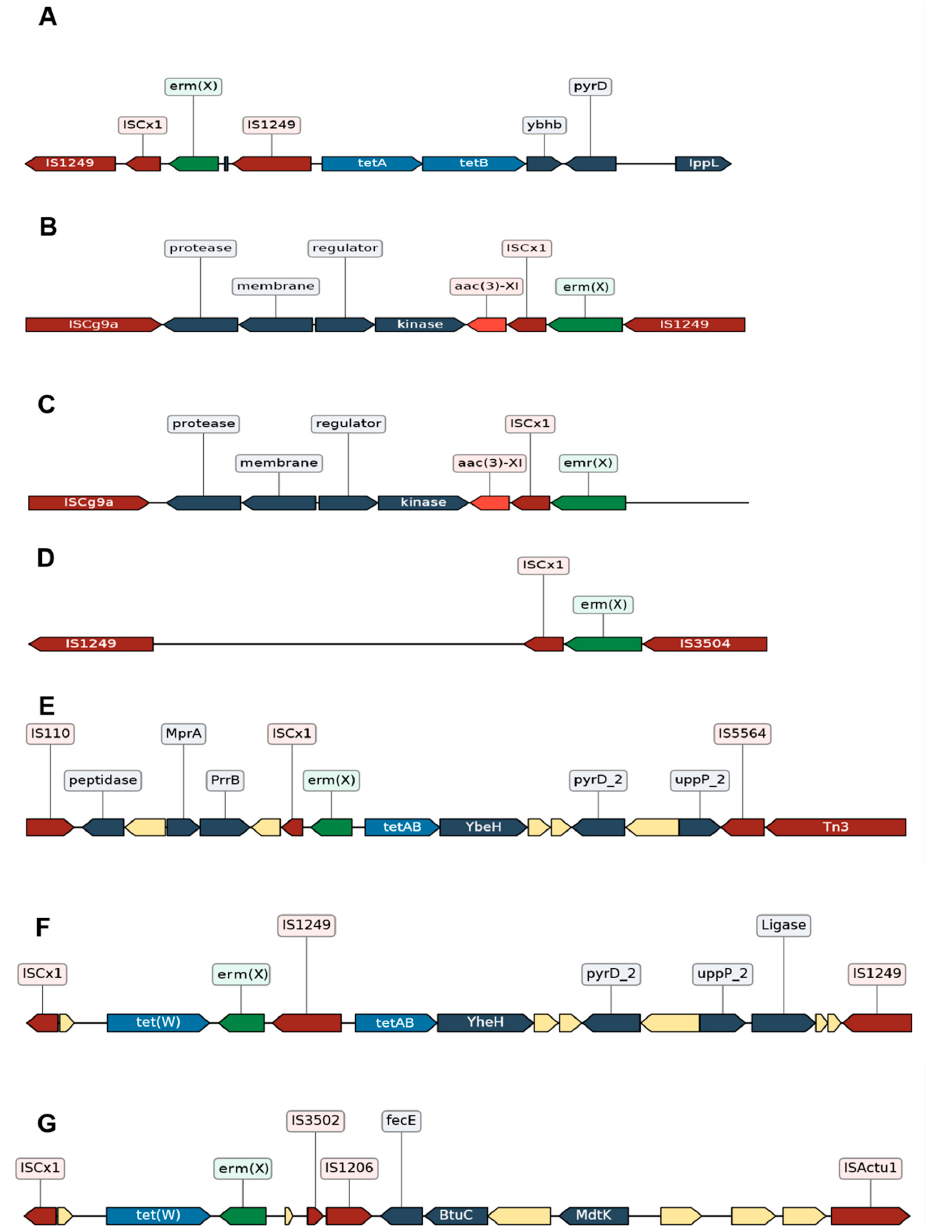
Figure 2. Genomic context of Tn5432 . Illustrated sequences from the genomic context of Tn5432 found in studies by Nudel et al., 2018; Tauch et al., 2000; Wang et al., 2019. The mobile elements are represented in red (IS and Tn), hypothetical proteins are depicted in the empty boxes, the genes directly unrelated to the resistance to antibiotics are in dark blue. ( A ) Tn5432 flanked by two IS1249 elements transports the erm(X) gene (in green) to its corresponding right, region II of the pTP10 plasmid of C. striatum that contains the tetA/tetB genes (in light blue). ( B – D ) Regions with the same genomic context as Tn5432 found in strains in Boston, USA [16], but in addition to the erm(X ) gene, this region contains the aac(3)-XI gene (in orange). ( E – G ) Regions with the same genomic context as Tn5432 found in Beijing, China [33]. The erm(X) gene, the tetA/tetB genes, and the tet(W) gene can be seen. ( E ) Note that it is the same genomic context; if erm(X) is located in the center, on the right can be seen segment II of the pTP10 plasmid in the isolates from China, and on the left the same segment of the isolates from the USA although annotated as protease, membrane, regulator, and kinase. ( B – D ) correspond to the genes annotated as peptide , hypothetical protein (associated with membrane), MprA (a regulator) and PrrB (a kinase). The representation of the sequences was done with the DNA Features Viewer tool [68] by using as references the accession numbers AF024666.2 ( A ), GCA_002804085.1 ( B ), GCA_002803965.1 ( C ), SRR5120233 ( D ), GCA_015945985.1 ( E ), GCA_015946165.1 ( F ), GCA_015946545.1 ( G